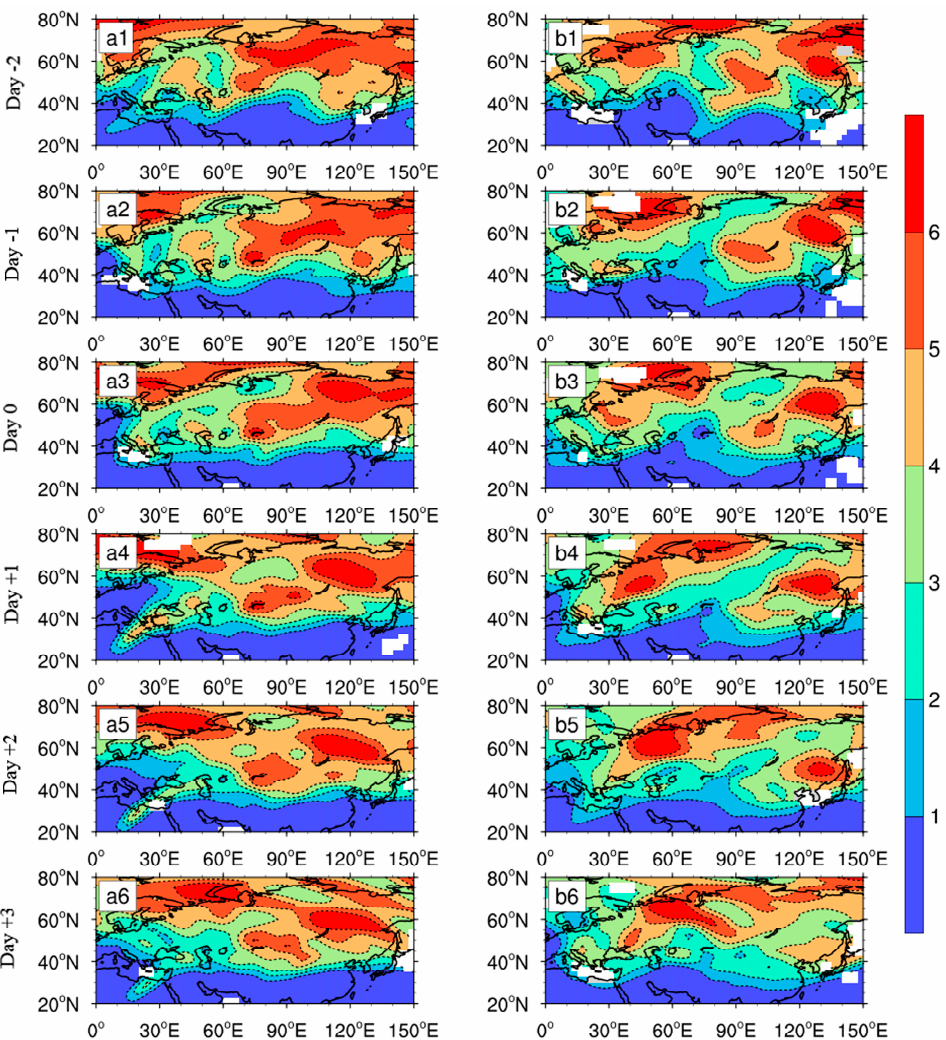
Figure 7. The Ertel’s Potential Vorticity (PV) on the 315 K isentropic surface (unit: PVU, 1 PVU = 10 − 6 · K · m 2 · kg − 1 · s − 1 ). (a1–a6, b1–b6 indicate PV from January 16 to 21 in 2008 and January 19 to 24 in 2016, respectively. The isoline interval is 1 PVU.)